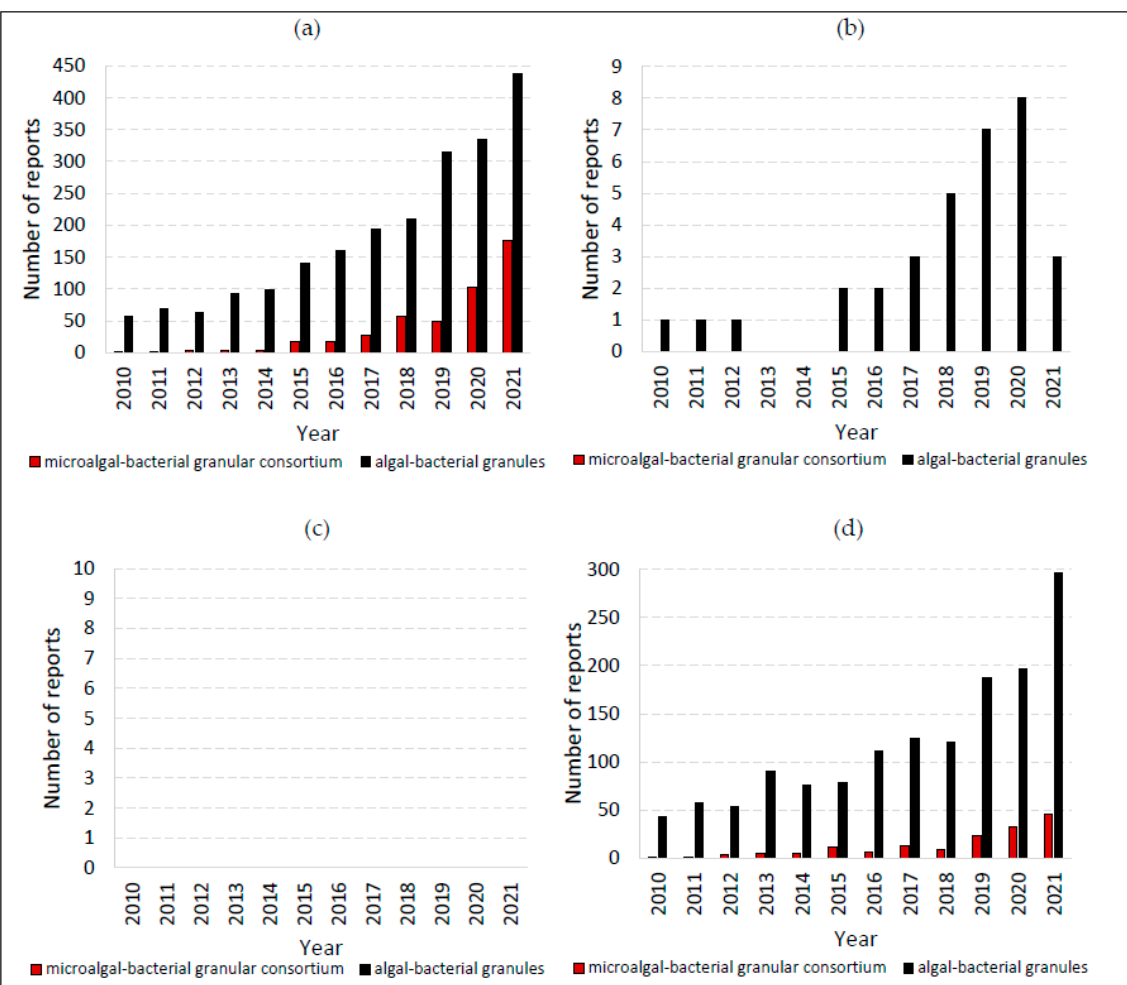
Figure 5. Number of articles found in ( a ) Google Scholar, ( b ) Scopus, ( c ) MDPI, and ( d ) Science Direct databases between 2010 and 2021 for the keywords “microalgal-bacterial granular consortium” and “algal-bacterial granules”. Accessed 30 October 2022.